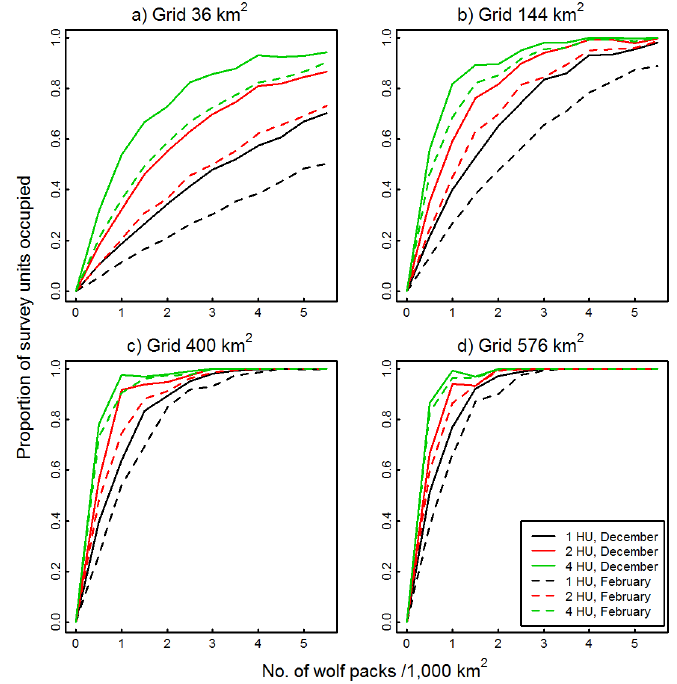
Figure 2. Effects of variation in wolf pack cohesion on occupancy–abundance relationships. Occupancy–abundance relationships were estimated from the proportion of survey units in which wolf tracks were detected during simulated aerial surveys as a function of wolf pack density (No. packs/1,000 km 2 ). Movements of one, two, or four wolf hunting units (HU) were simulated using December or February step length and turn angle distributions from 2-hour GPS locations from 11 wolves, northeastern Alberta, Canada, 2006–2008. Simulations were run for four grids: (a) 36 km 2 , (b) 144 km 2 , (c) 400 km 2 , and (d) 576 km 2 .